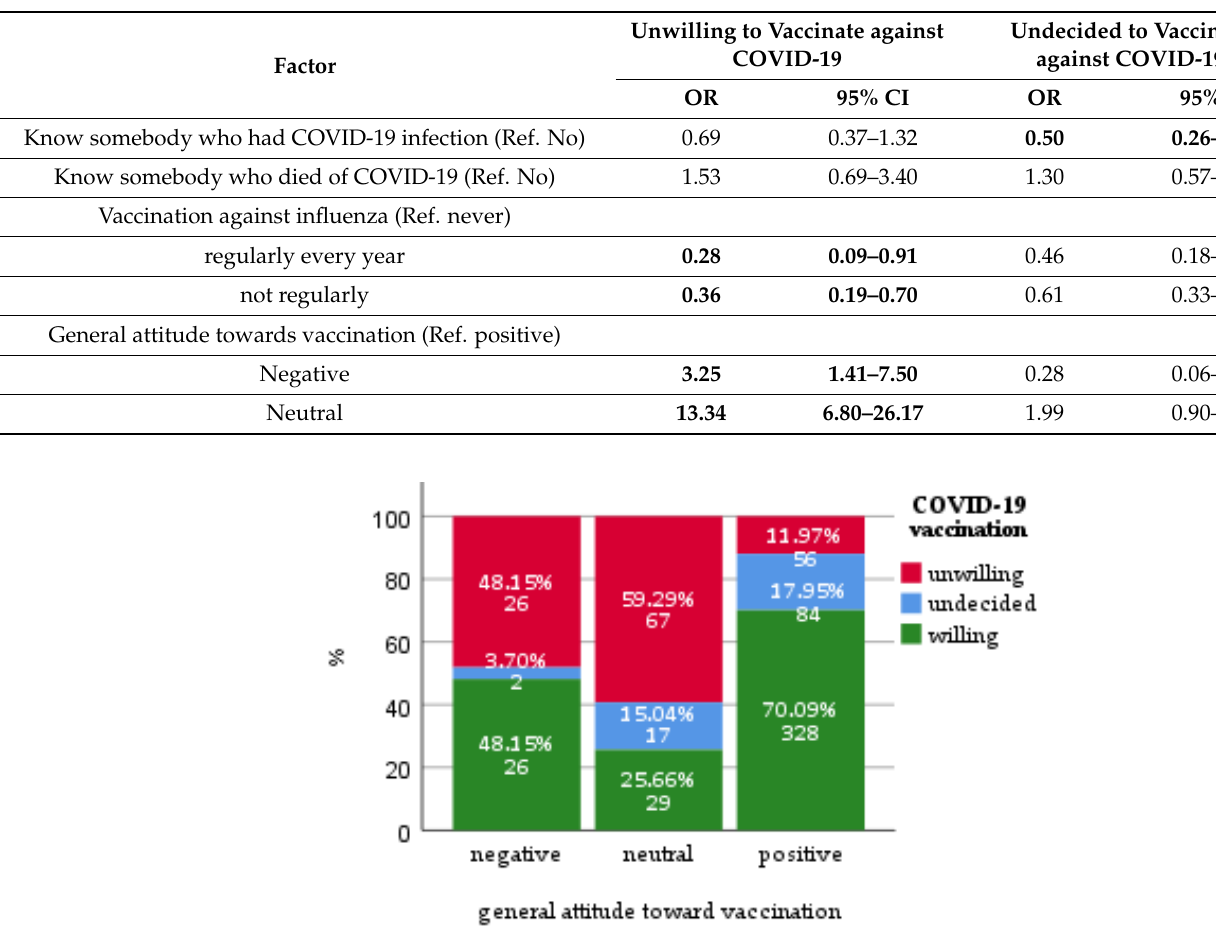
Figure 2. Willingness to get vaccinated against COVID-19 stratified by a general attitude toward vaccination.